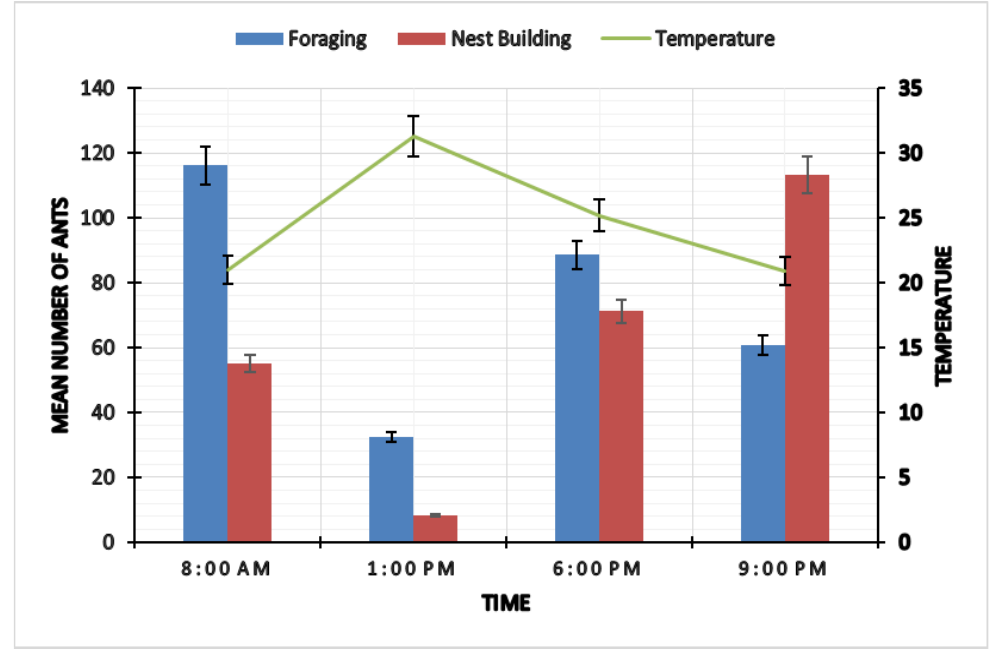
Fig 5 . Relationship between temperature and the number of weaver ants performing foraging and nest building